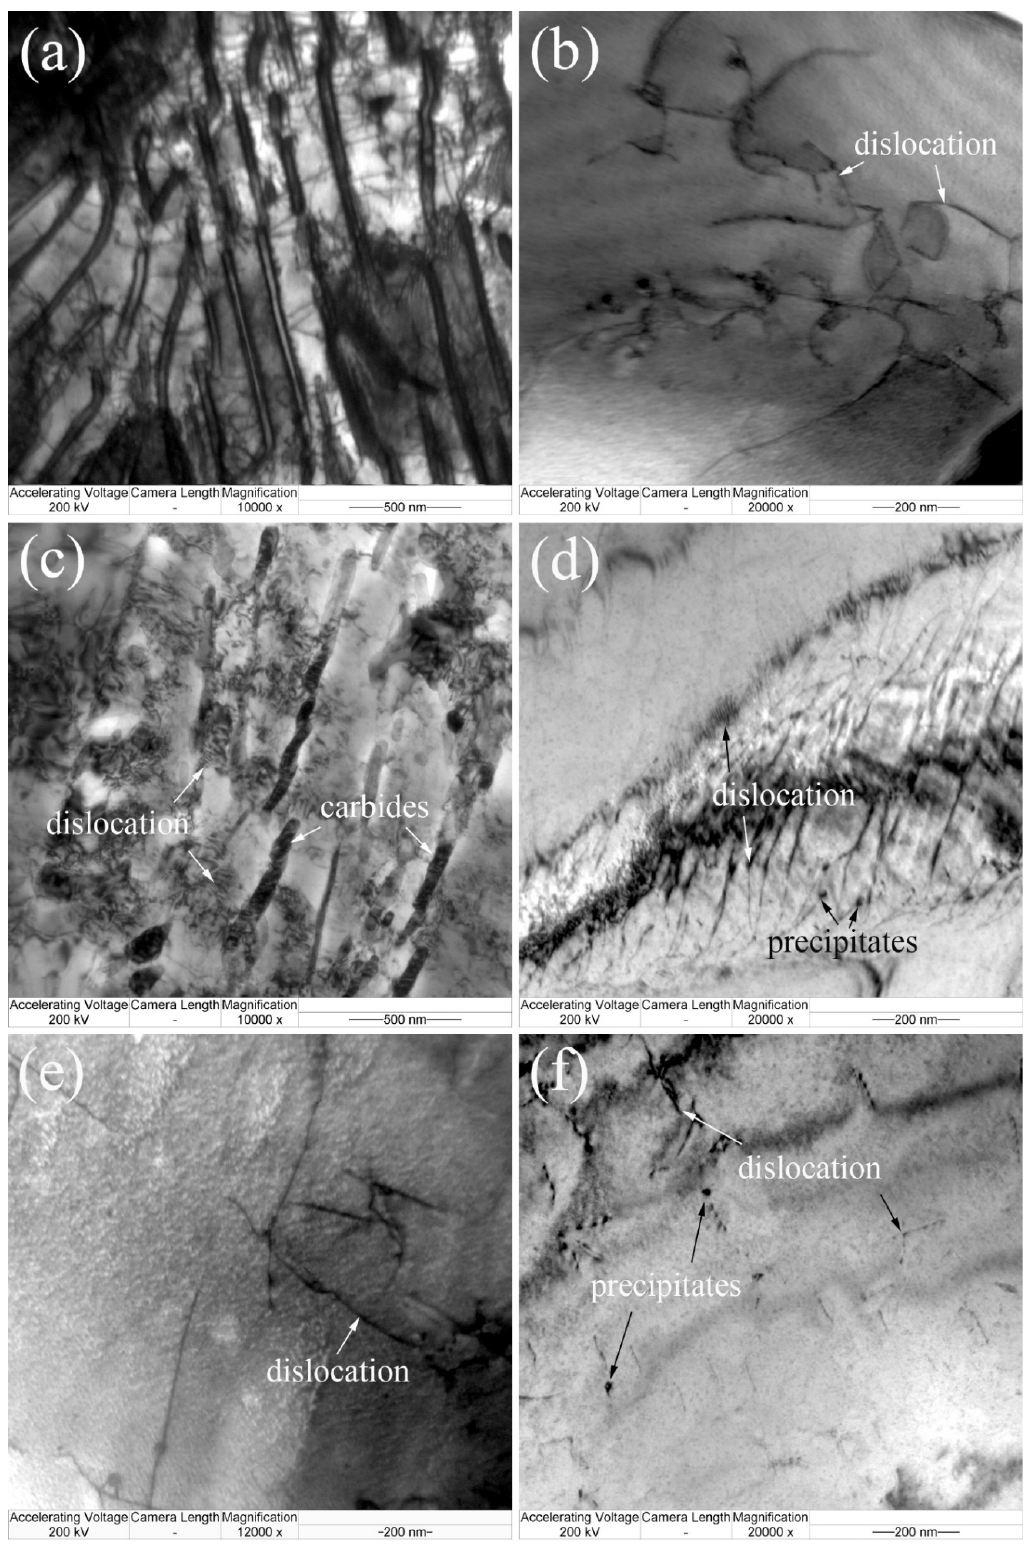
Figure 6. Bright field TEM of steels: ( a , b ) N1-HR, ( c , d ) N2-HR, ( e ) N1-HT, ( f ) N2-HT.